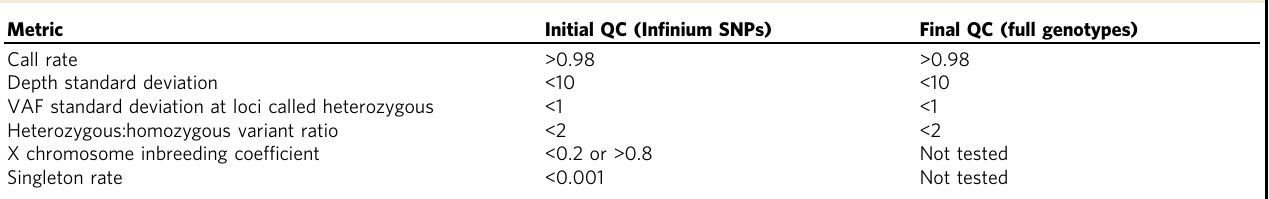
Table 5 Quality metric conditions for samples to pass quality